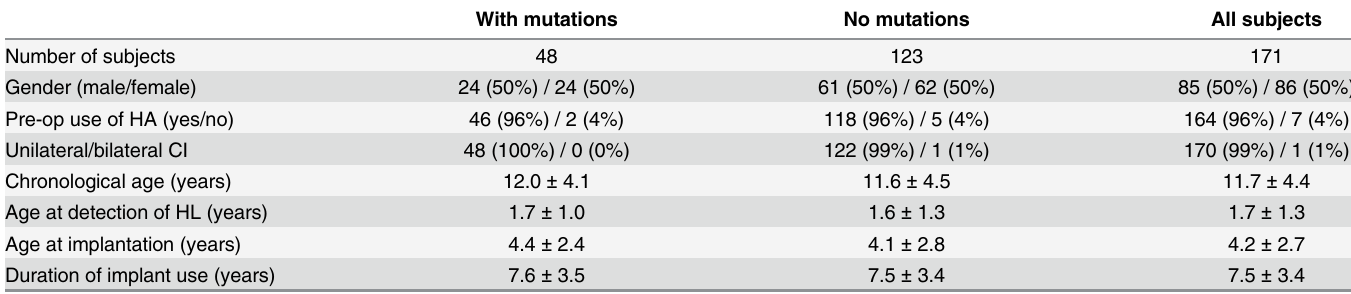
Table 3. Demographic information of 171 subjects with and without mutations in GJB2 , SLC26A4 and the mitochondrial 12S rRNA gene.